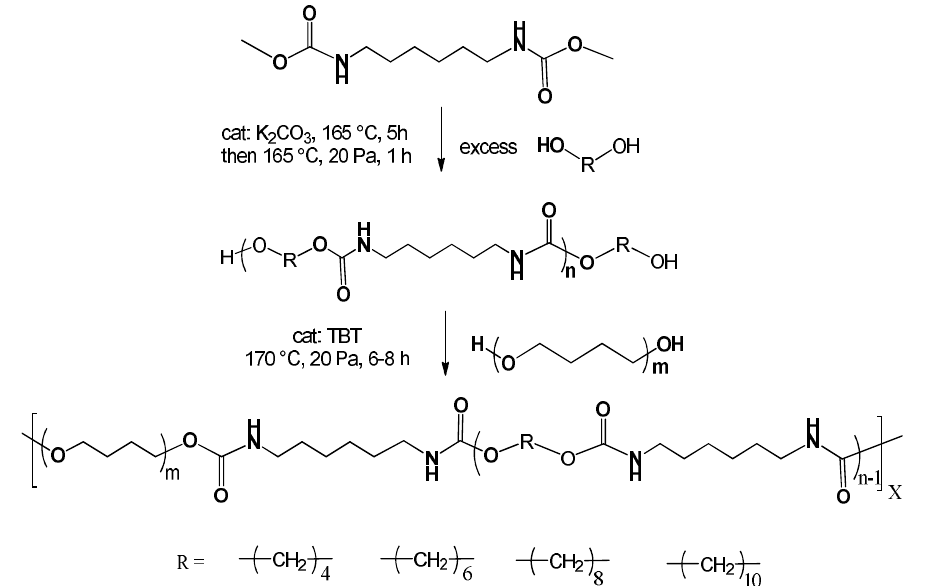
Figure 1. Scheme for the preparation of PEU based on different hard segments.